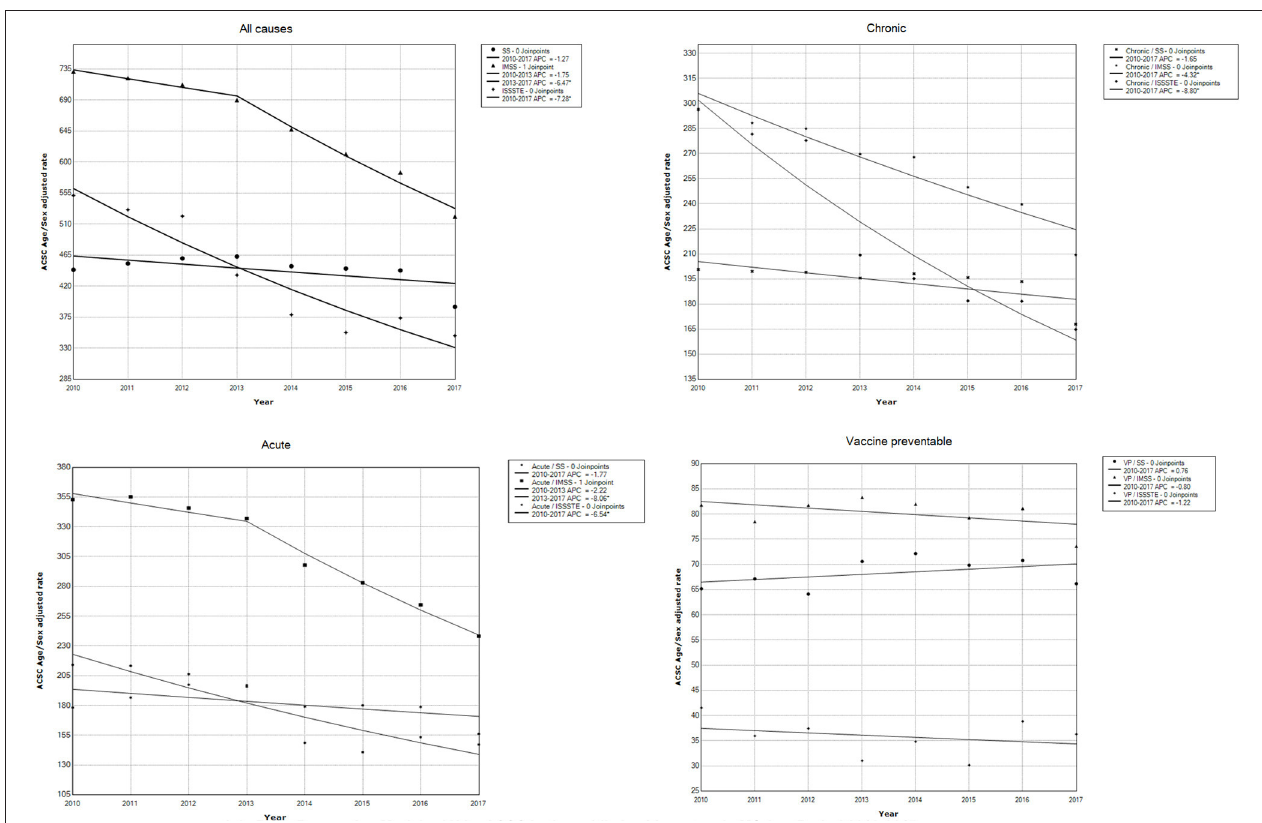
FIGURE 2 | Join Point Regression Models. AH by ACSC in the public health system in México. Period